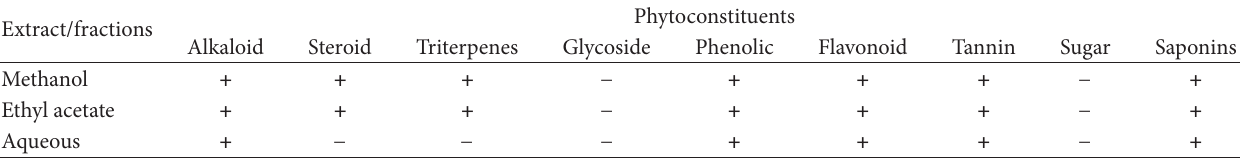
Table 1: Phytoconstituents present in L. coromandelica .